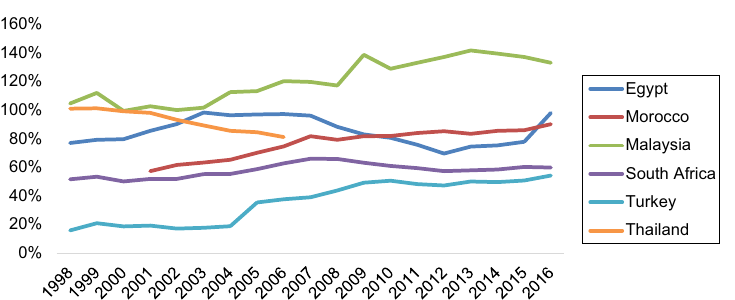
Figure 4. Ratio of M2 to GDP in six middle-income countries, 1965-2016